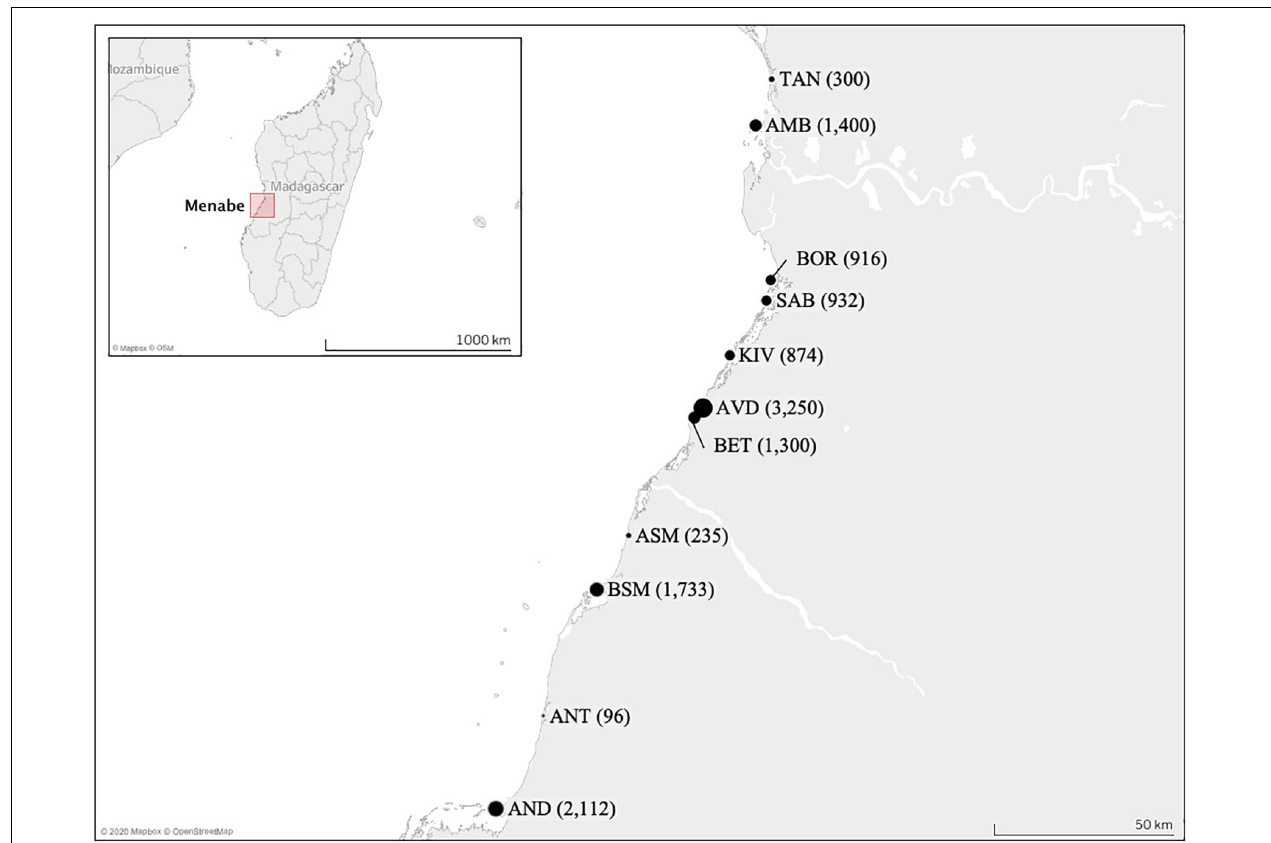
FIGURE 1 | Map of the study area showing the positions of the 11 village landing sites sampled across the Menabe region of western Madagascar. The size of the circle represents their relative population size in 2011, this is also shown in parentheses (reported by village presidents or in Raharison, unpublished). (TAN, Tanambao Port; AMB, Ambakivao; BOR, Borongeny; SAB, Sabora; KIV, Kivalo Centre; AVD, Avaradrova; BET, Betania; ASM, Ankevo sur Mer; BSM, Belo sur Mer; ANT, Antseranandaka; AND, Andranompasy).